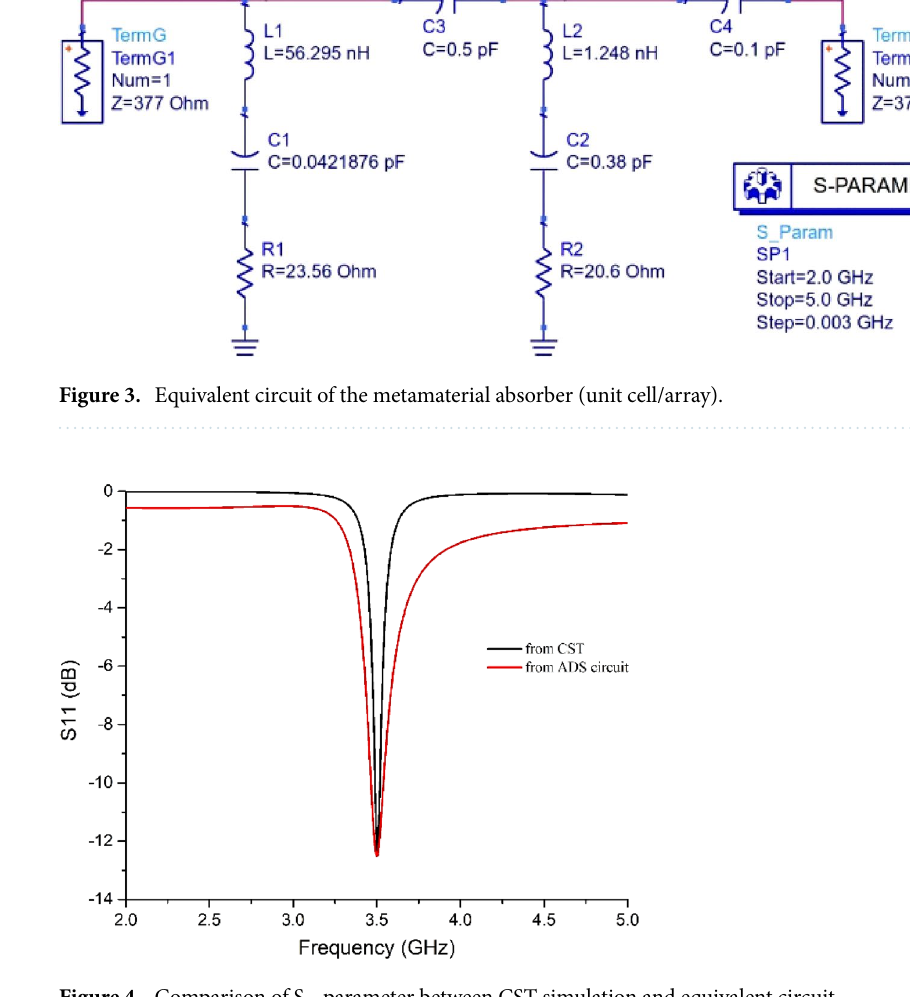
Figure 4. Comparison of S 11 parameter between CST simulation and equivalent